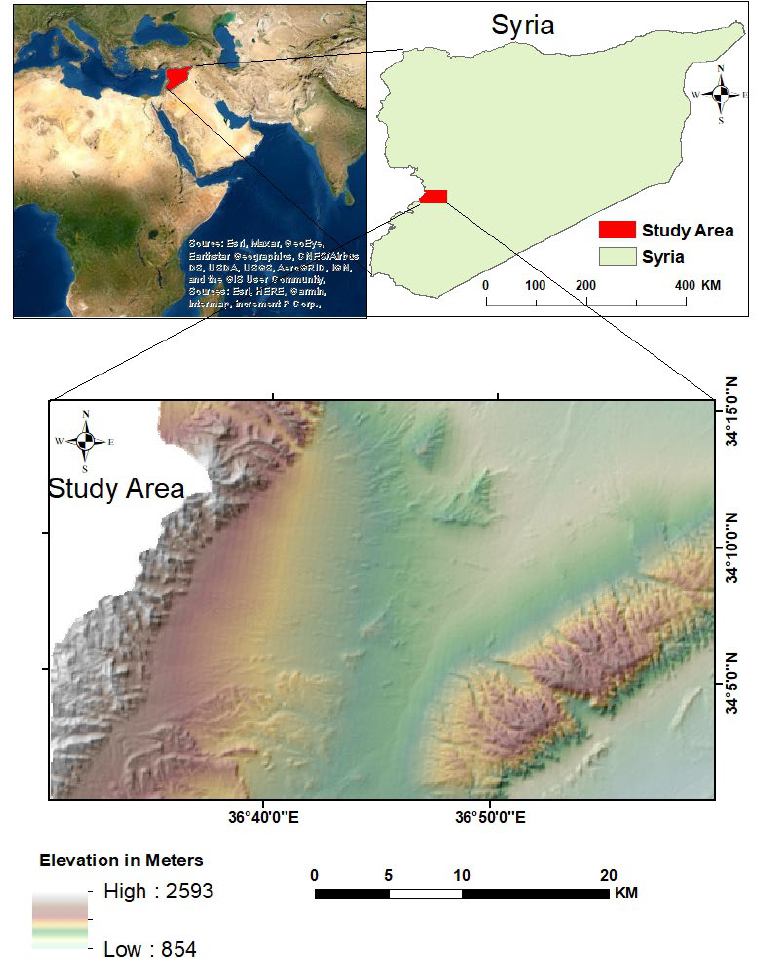
Figure 1. The study area of Al-Qalamoun.